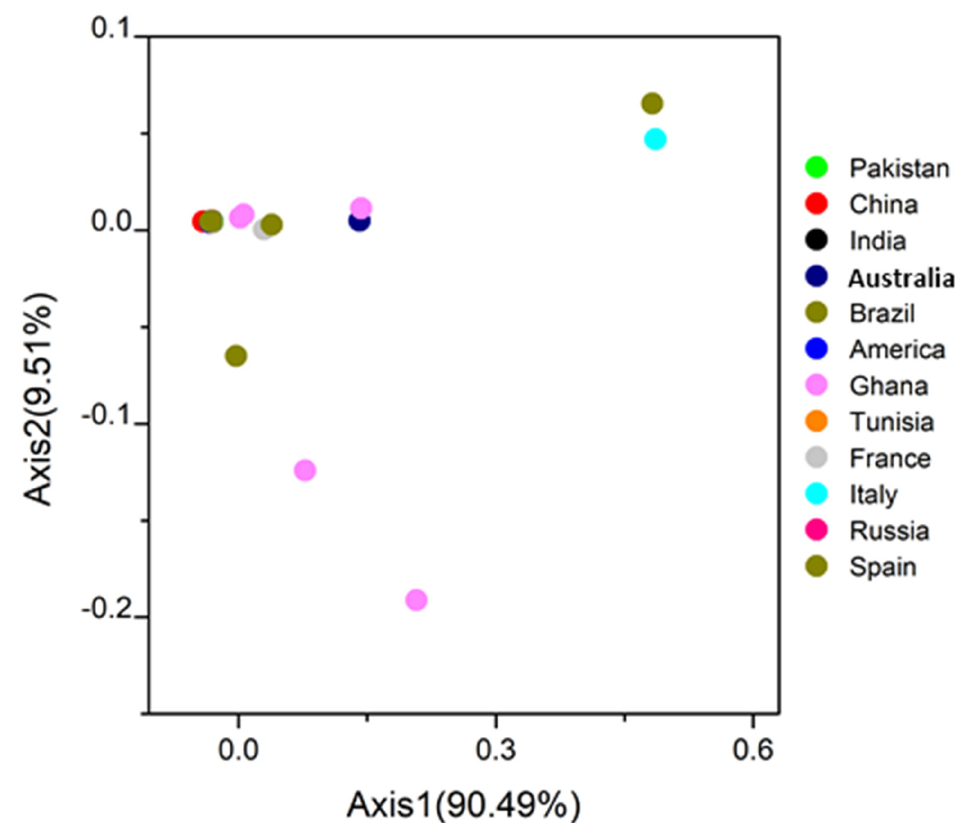
Figure 5. Variation analysis in SARS-CoV-2 genomes: based on the RSCU values, all the strains are plotted in the variance plane. The first and second principal axes represent different geographical origins. Each point represents a strain and shows in different colors.